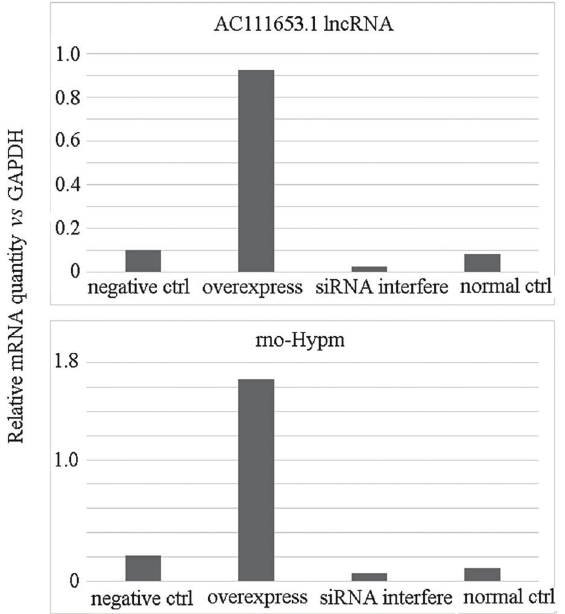
Figure 4. QPCR relative mRNA quanti fi cation. Upper panel shows rno - lncRNA AC111653.1 levels. Lower panel shows rno-Hypm mRNA levels in each group. Negative ctrl: pcDNA3.1 vector transfection; overexpress: pcDNA3.1-lnc-AC111653.1 transfection; siRNA interfere: siRNA-lnc-AC111653.1 transfec- tion; normal ctrl: normal cells without treatment. Figure 5. Novel lncRNA AC111653.1 was overexpressed after pcDNA3.1-lnc-AC111653.1 transfection. At the same time, its target hypm was also upregulated. Expression of AC111653.1 was reduced after siRNA transfection, and at the same time, its target hypm was downregulated. This suggested that novel lncRNA AC111653.1 was positively associated with hypm regulation in rats.